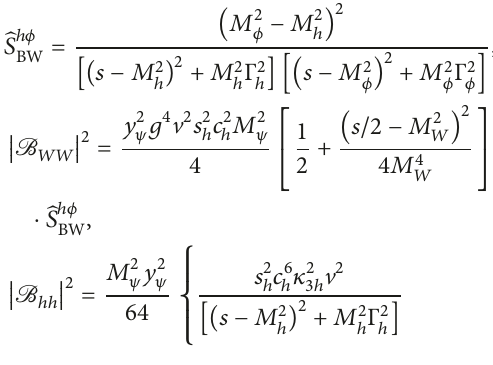
Figure 4: The contours of 𝜎 휙 × BR 훾훾 (in fb) and regions (darker to lighter shades) of 𝜅 2 Γ < 0.1 (red), 0.1 < 𝜅 2 Γ < 0.5 (blue), 0.5 < 𝜅 2 Γ < 1 (pink), 1 < 𝜅 2 < 2 (gray), 2 < 𝜅 2 < 3 (orange), and 𝜅 2 > 3 (light green). Parameters not varied along the axes are fixed at 𝑠 Γ Γ Γ 𝑀 = 1200 GeV, 𝑀 = 1000 GeV, 𝑦 = 2 , and 𝑦 = 2.5 . These parameter choices are motivated by obtaining the observed dark matter relic 푈 휙 휓 푈 density and direct detection